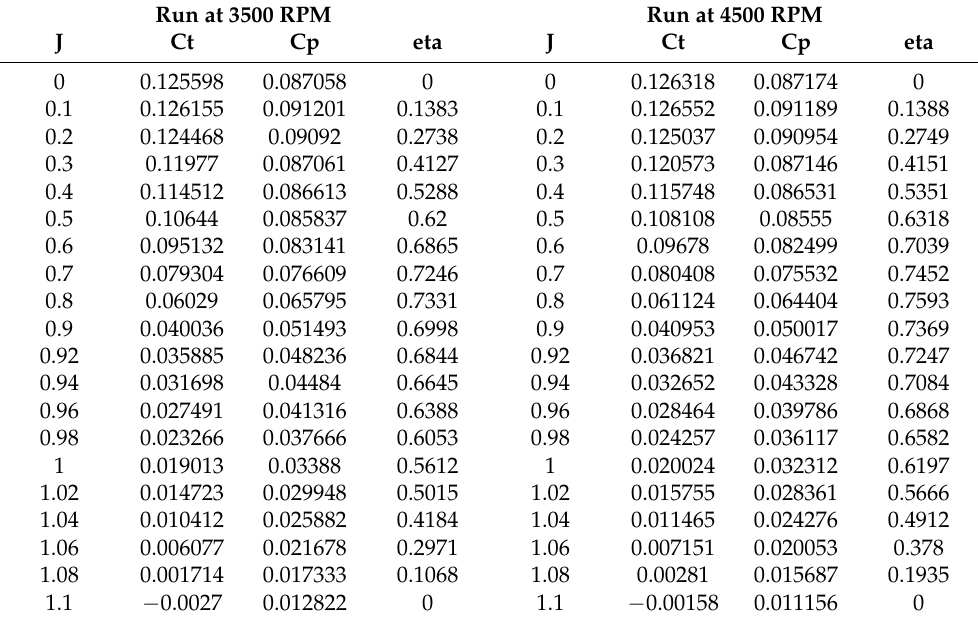
Table A17. BEMT 14 × 12 APC propeller data.